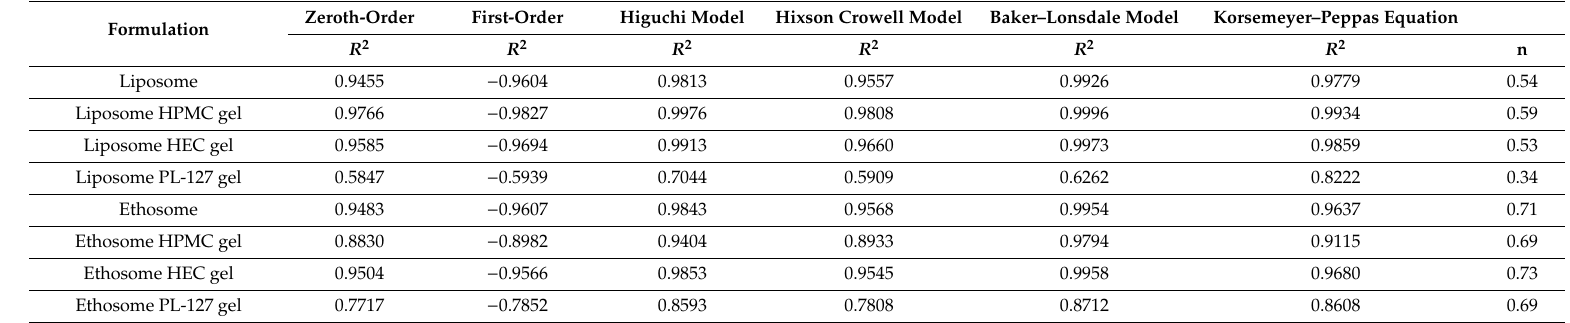
Table 3. Kinetic analysis of anthralin release